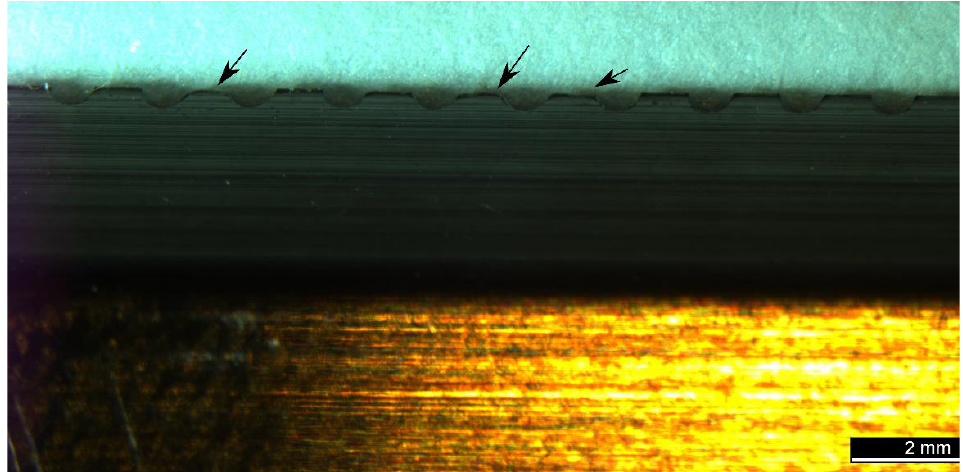
Figure 8. Coarsely structured knife viewed under the loupe. Damaged sections in the knife structure are observable. The black arrows indicate damaged areas.